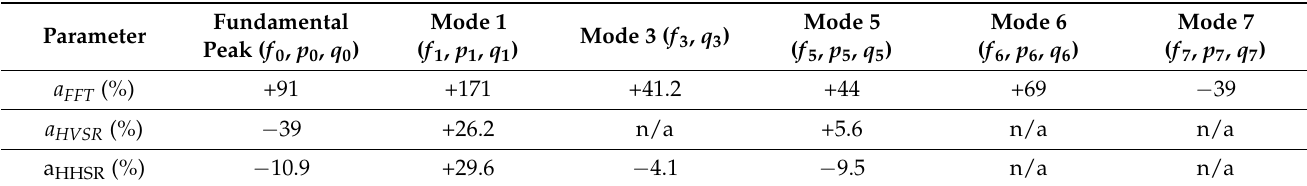
Table 3. Cumulated changes (in %) in spectral peak amplitudes throughout the bolting works (comparison between before works and after injection i 2 ). n/a: not spotted by HVSR technique.